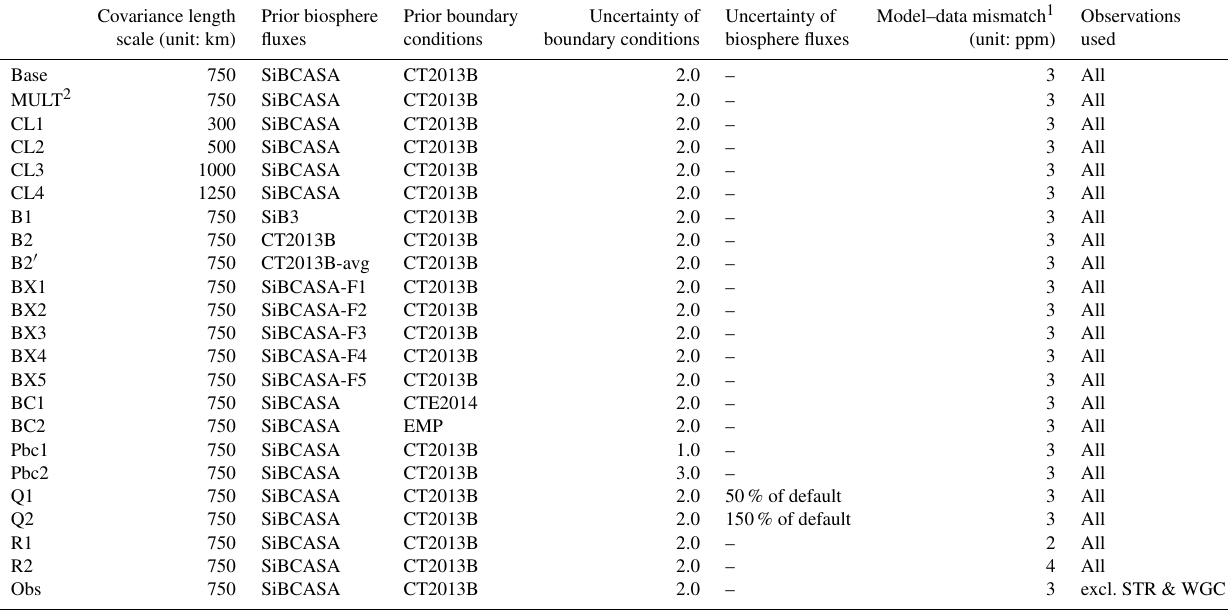
Table 2. Summary of the base and sensitivity runs using CTDAS-Lagrange. Covariance